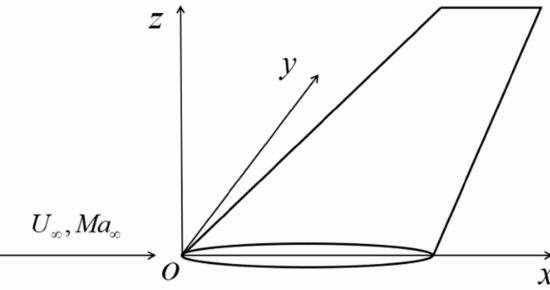
Figure 2. Definition of coordinates in the Euler